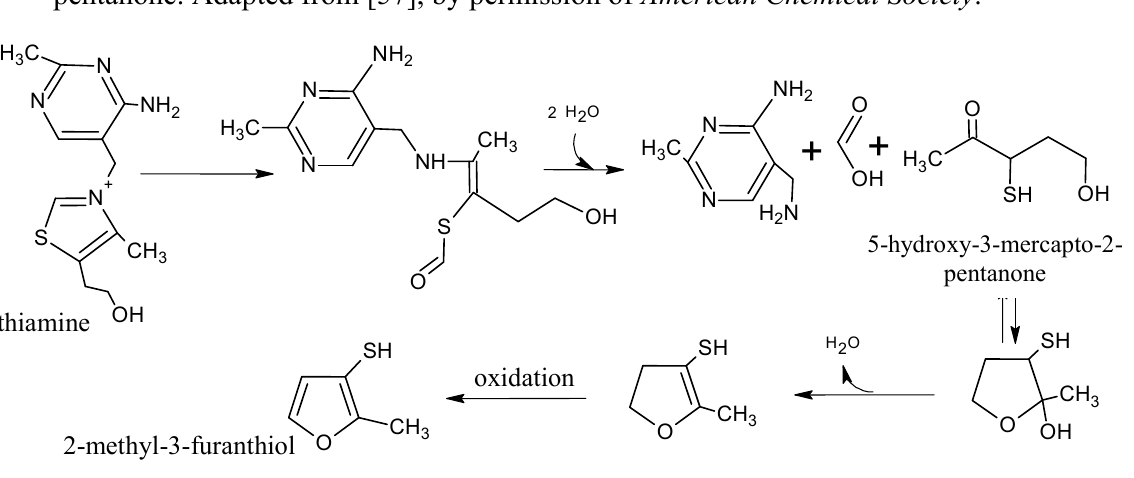
Scheme 6. Formation of 2-methyl-3-furanthiol from thiamine via 5-hydroxy-3-mercapto-2- pentanone. Adapted from [57], by permission of American Chemical Society